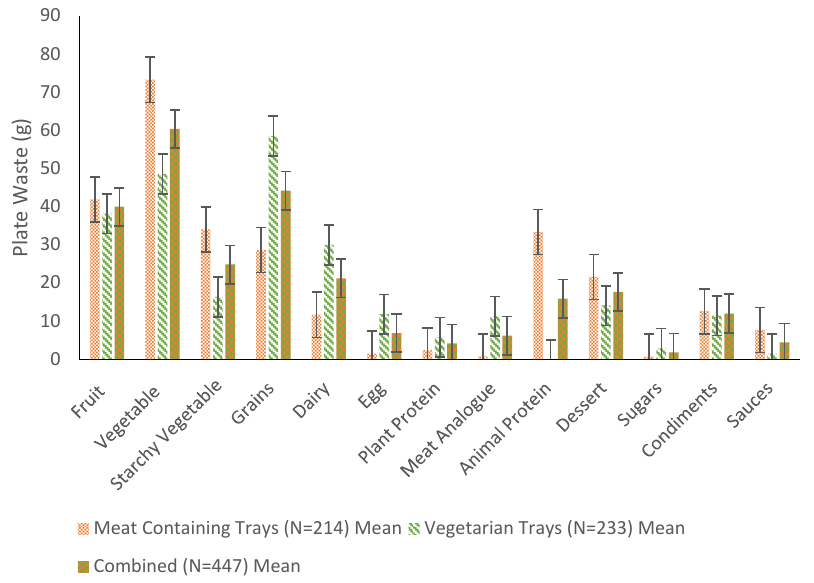
Figure 1. Categories of foods and their respective amounts of waste differentiated by meal type. Error bars represent the standard error of mean.